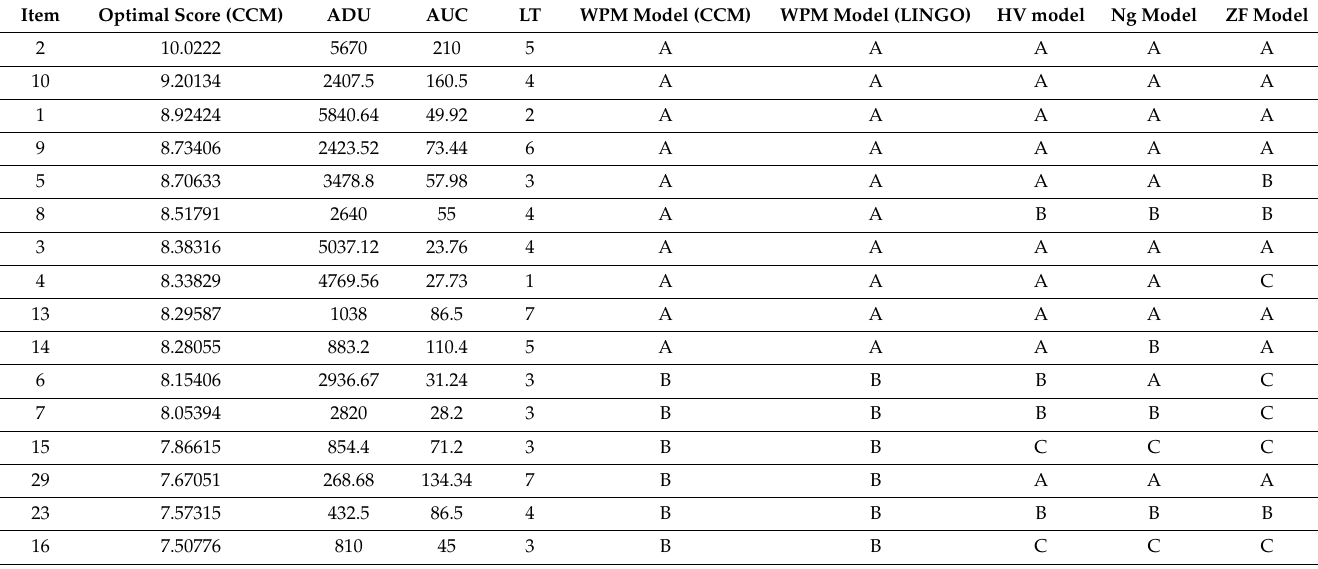
Table 2. Comparison of ABC classifications using the optimal weighted product model (WPM), Zhou and Fan (ZF) model, Ng model, and Hadi-Vencheh (HV) model inventory